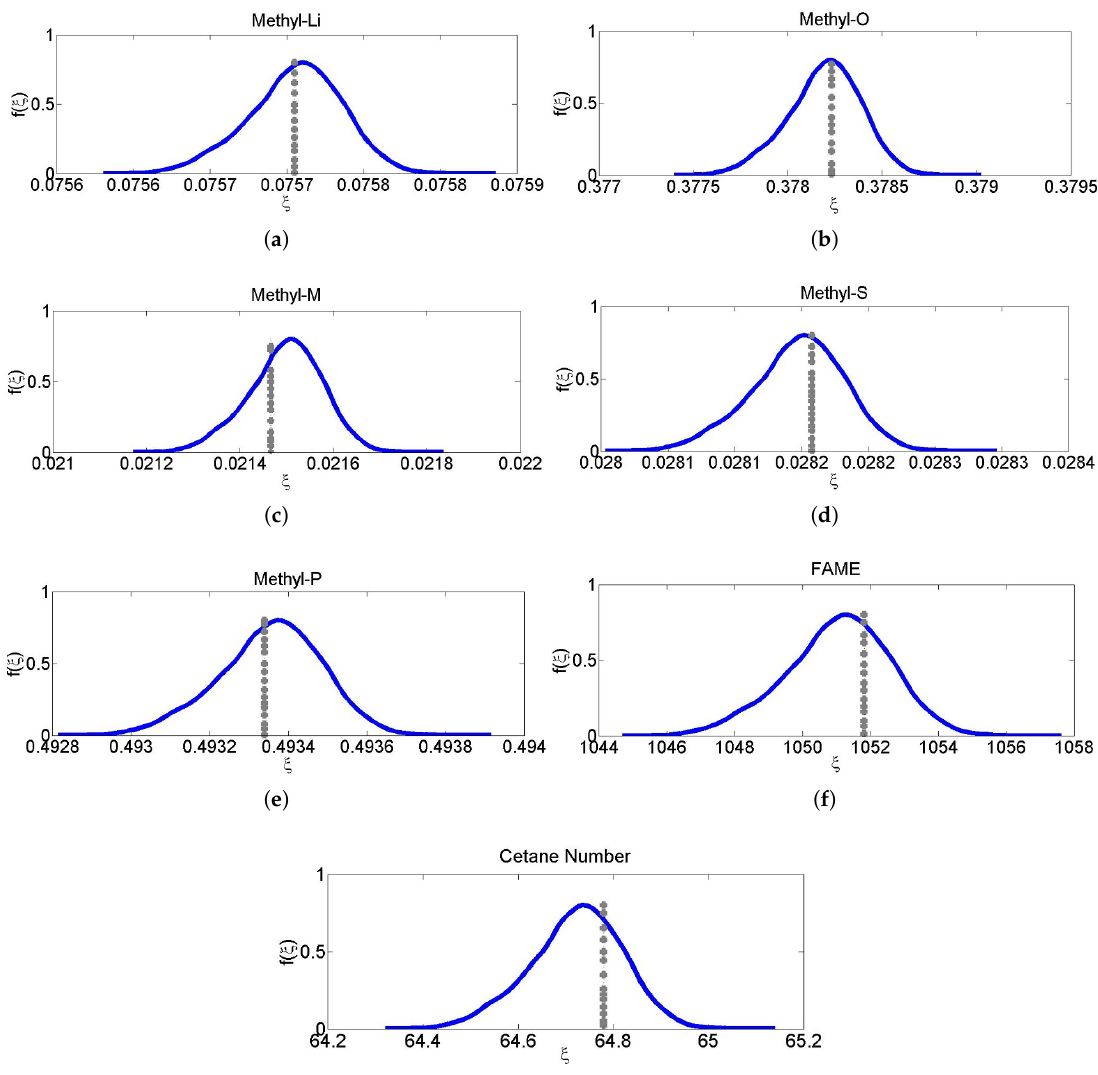
Figure 7. ( a – g ) PCE based Predicted distribution of measured composition, cetane number and flow rate of FAME (blue lines), measured values of composition, cetane number and flow rate of fame (grey dotted